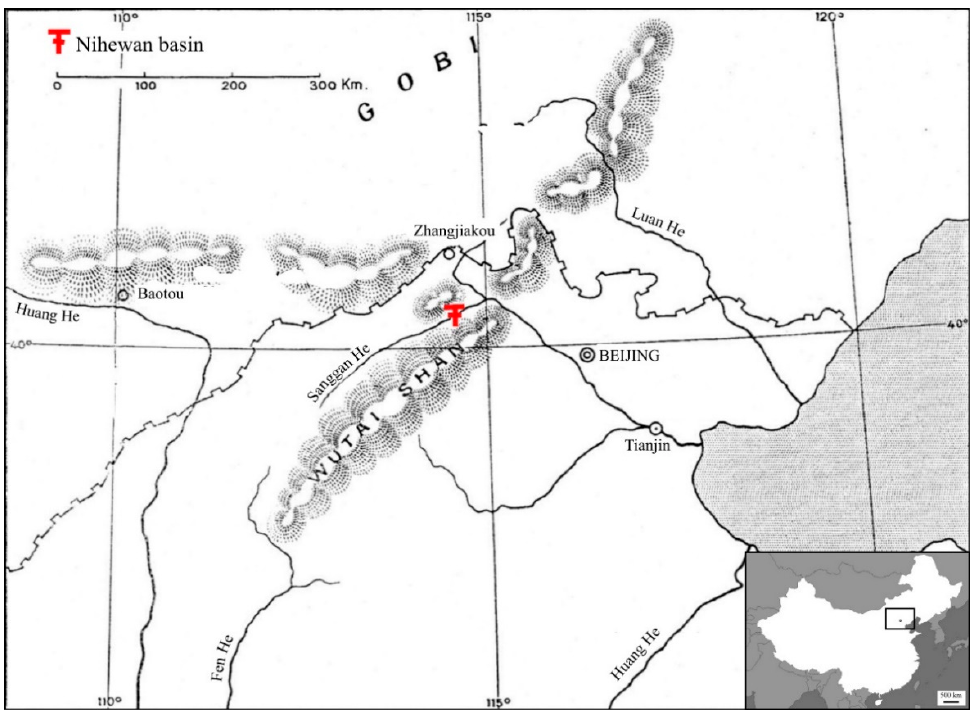
Figure 1. Map of part of northern China showing location of the Nihewan Basin, WNW of Beijing, with general location in China (small map at lower right corner). Modified after Teilhard de Chardin and Piveteau [2].